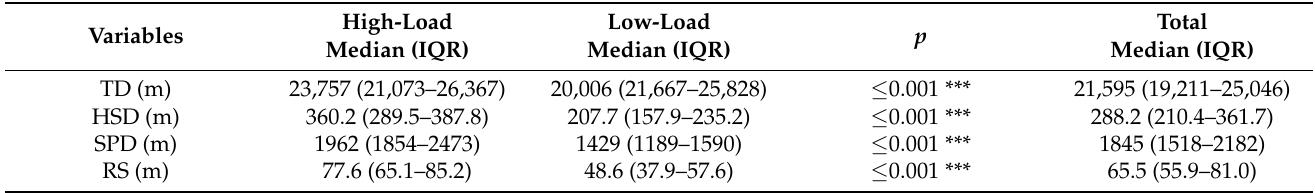
Table 1. Descriptive information of sprint variables based on high- and low-load levels.